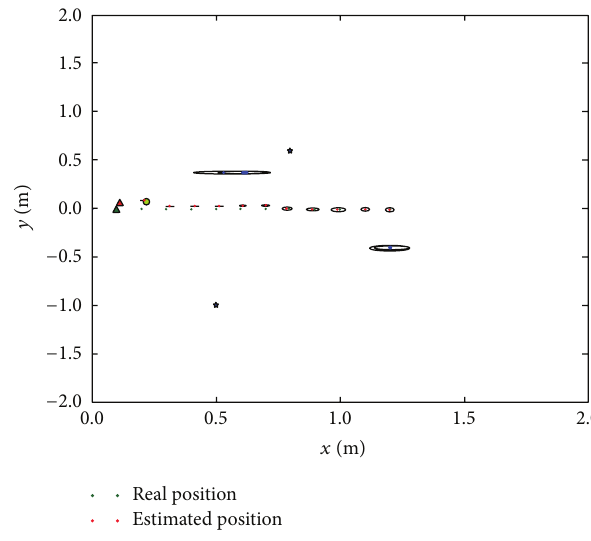
Figure 9: The experiment motion result of Robot SLAM without closed-loop controller.